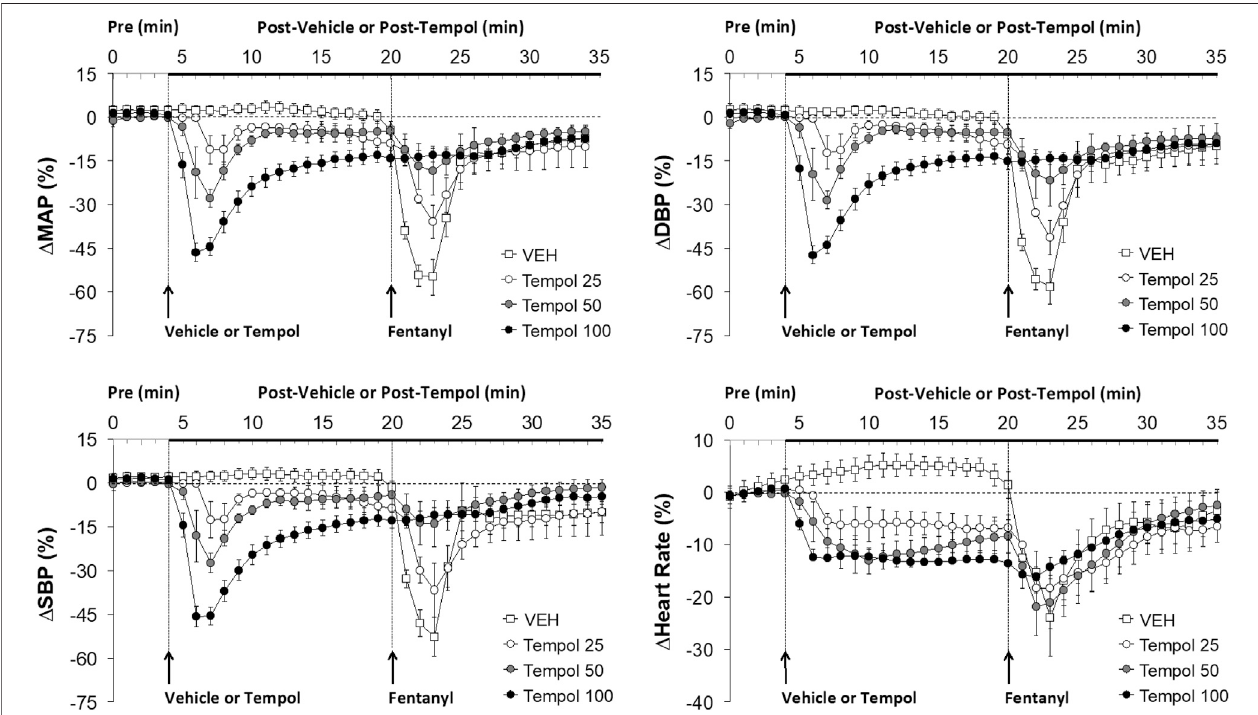
FIGURE 2 | The changes in mean (MAP), diastolic (DBP) and systolic (SBP) arterial blood pressures and heart rate elicited by bolus injections of vehicle (VEH) or Tempol(25,50or100 mg/kg,IV)andsubsequentinjectionsoffentanyl(5 μ g/kg,IV)iniso fl urane-anesthetized rats.Therewere12ratsinthevehiclegroup, and3,5and 12 rats in the 25, 50 and 100 mg/kg Tempol groups, respectively. The data presented are mean ±